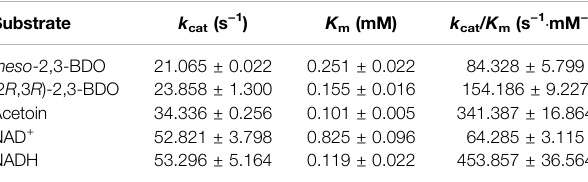
TABLE 3 | Kinetic parameters of R , R -BDH.